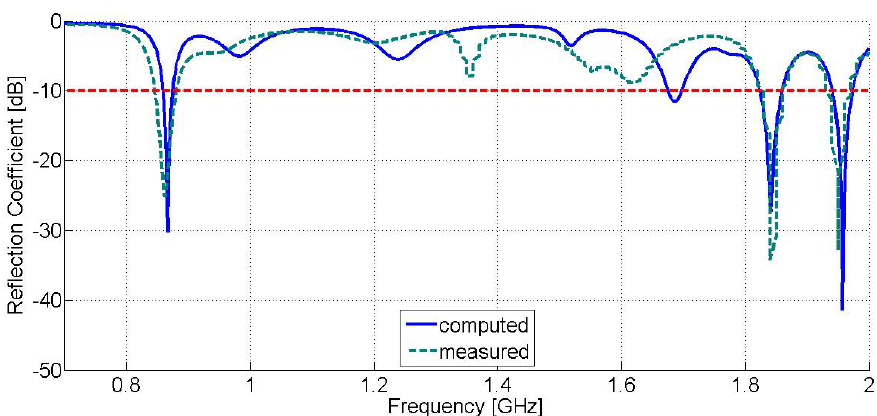
Figure 6. Reflection coefficient ( S 11 magnitude) versus frequency of the proposed modified E-shaped patch antenna (Computed results are displayed in blue solid line, whereas measured results are displayed in dark green dash line. The red dash line represents the − 10 dB